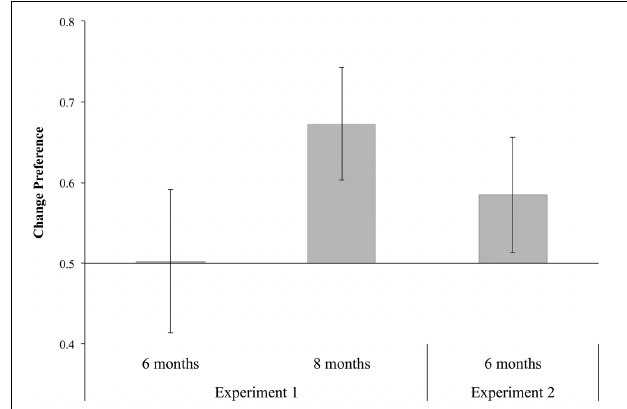
FIGURE 3 | Average change preference scores for 6- and 8-month-old infants in Experiment 1 and 6-month-old infants in Experiment 2 during the analysis window of the test array (200–1533ms post-change in Experiment 1, and 200–1717ms in Experiment 2). Error bars represent 95% confidence